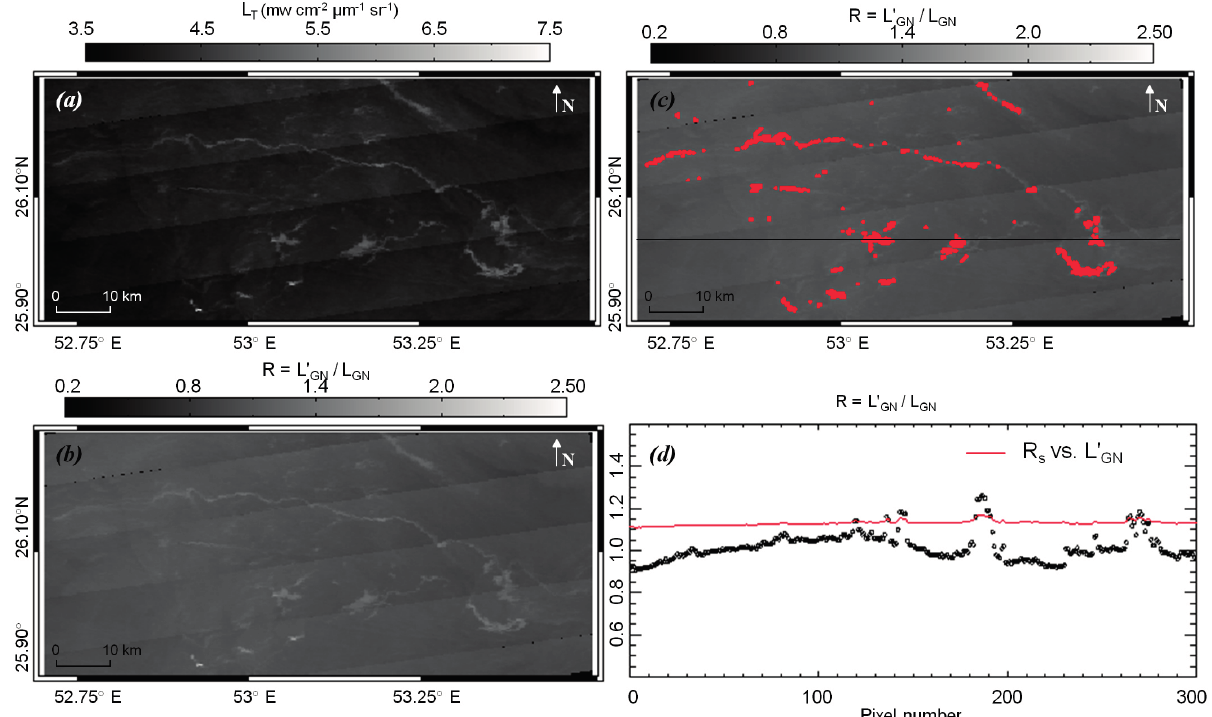
Figure 8. Arabian Gulf oil spill event (Scene 11). The methodology steps in brief: ( a ) input data, TOA radiance L t (859 nm); ( b ) ratio map R ; ( c ) oil spills detected in R ; ( d ) black dots are R values along the black transect in (c), and the red line is R s values along the same transect, as inferred from the curves of Figure